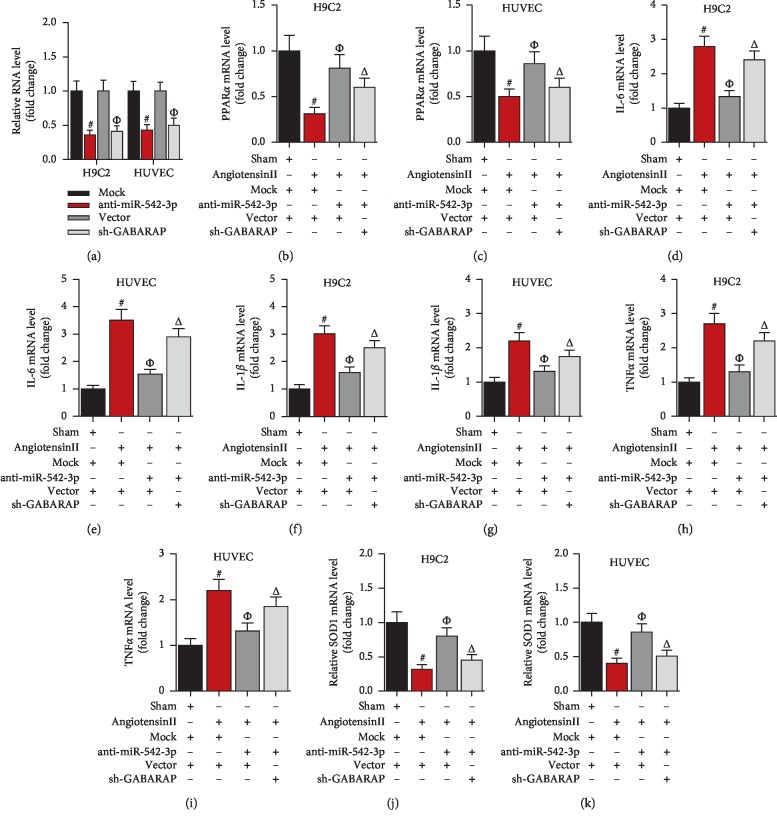
miR-542-3p regulates oxidation and inflammation by targeting GABARAP in cell lines. (a) Real-time PCR analysis of miR-542-3p or GABARAP in cell lines after transfection for 48 h; #P < 0.001 versus Mock and ΔP < 0.05 versus vector. (b, c) Real-time PCR analysis of PPARα expression in H9C2 and HUVEC cells after 48 h transfection followed by 4 h angiotensin II-stimulation; #P < 0.001 versus the sham + Mock + vector, ΦP < 0.05 versus the angiotensin II + Mock + vector, and ΔP < 0.05 versus the angiotensin II + anti-miR-542-3p + vector. (d, e) Real-time PCR analysis of IL-6 expression in H9C2 and HUVEC cells after 48 h transfection followed by 4 h angiotensin II-stimulation; #P < 0.001 versus the sham + Mock + vector, ΦP < 0.05 versus the angiotensin II + Mock + vector, and ΔP < 0.05 versus the angiotensin II + anti-miR-542-3p + vector. (f, g) Real-time PCR analysis of IL-1β expression in H9C2 and HUVEC cells after 48 h transfection followed by 4 h angiotensin II-stimulation; #P < 0.001 versus the sham + Mock + vector, ΦP < 0.05 versus the angiotensin II + Mock + vector, and ΔP < 0.05 versus the angiotensin II + anti-miR-542-3p + vector. (h, i) Real-time PCR analysis of TNFα expression in H9C2 and HUVEC cells after 48 h transfection followed by 4 h angiotensin II-stimulation; #P < 0.001 versus the sham + Mock + vector, ΦP < 0.05 versus the angiotensin II + Mock + vector, and ΔP < 0.05 versus the angiotensin II + anti-miR-542-3p + vector. (j, k) Real-time PCR analysis of SOD1 expression in H9C2 and HUVEC cells after 48 h transfection followed by 4 h angiotensin II-stimulation; #P < 0.001 versus the sham + Mock + vector, ΦP < 0.05 versus the angiotensin II + Mock + vector, and ΔP < 0.05 versus the angiotensin II + anti-miR-542-3p + vector.